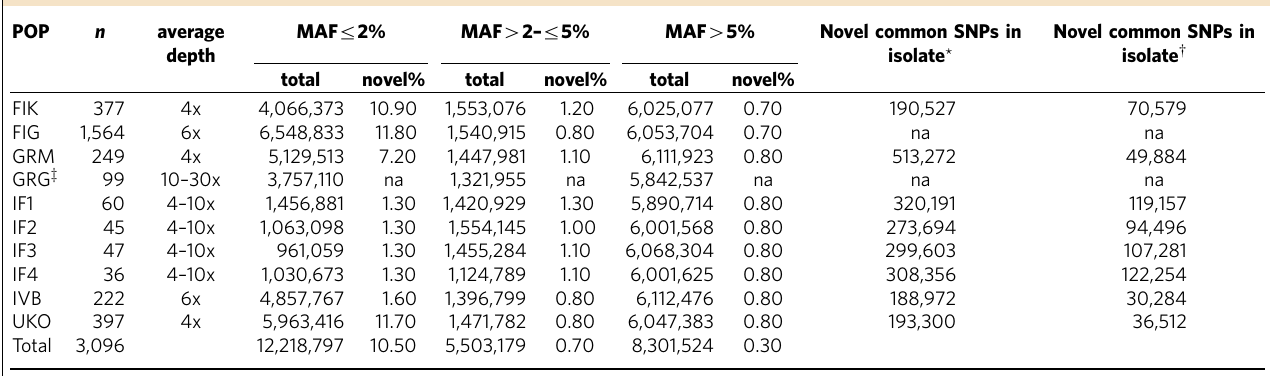
Table 1 | Summary of variants discovered in this study.